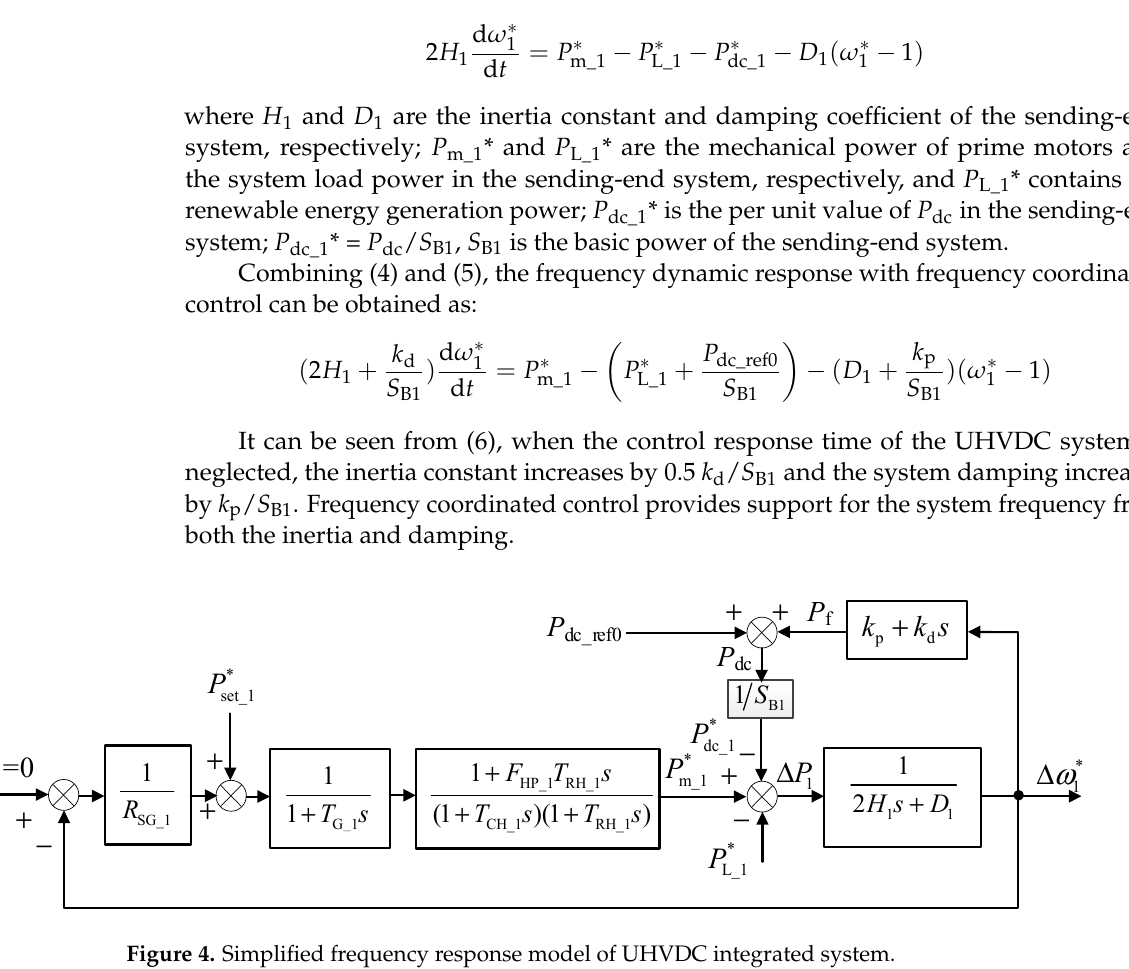
Figure 4. Simplified frequency response model of UHVDC integrated system.